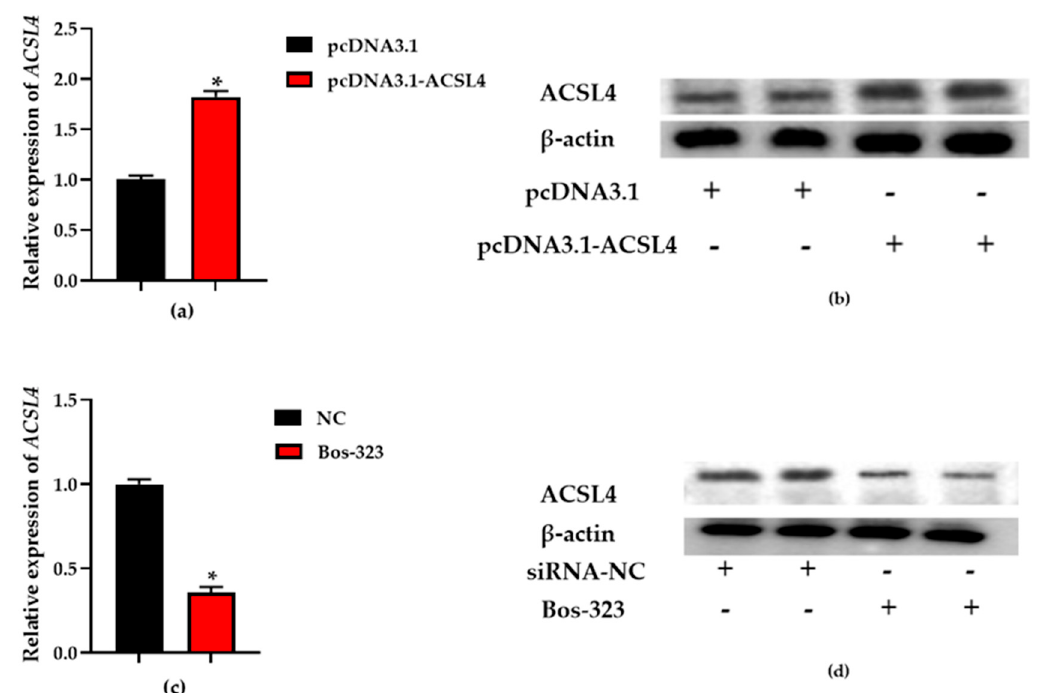
Figure 4. The relative expression of acyl-CoA synthetase long-chain family member 4 ( ACSL4 ). ( a , c ) BMECs were transfected with recombinant plasmid (pcDNA3.1-ACSL4) and blank plasmid (pcDNA3.1), and the ACSL4 expression level was quantified by qRT-PCR. ( b , d ) BMECs were transfected with pcDNA3.1-ACSL4 and Bos-323, respectively. The effect of pcDNA3.1-ACSL4 transfection for on ACSL4 protein expression was evaluated by western blot. Values are presented as the mean ± standard errors; *, p < 0.05.